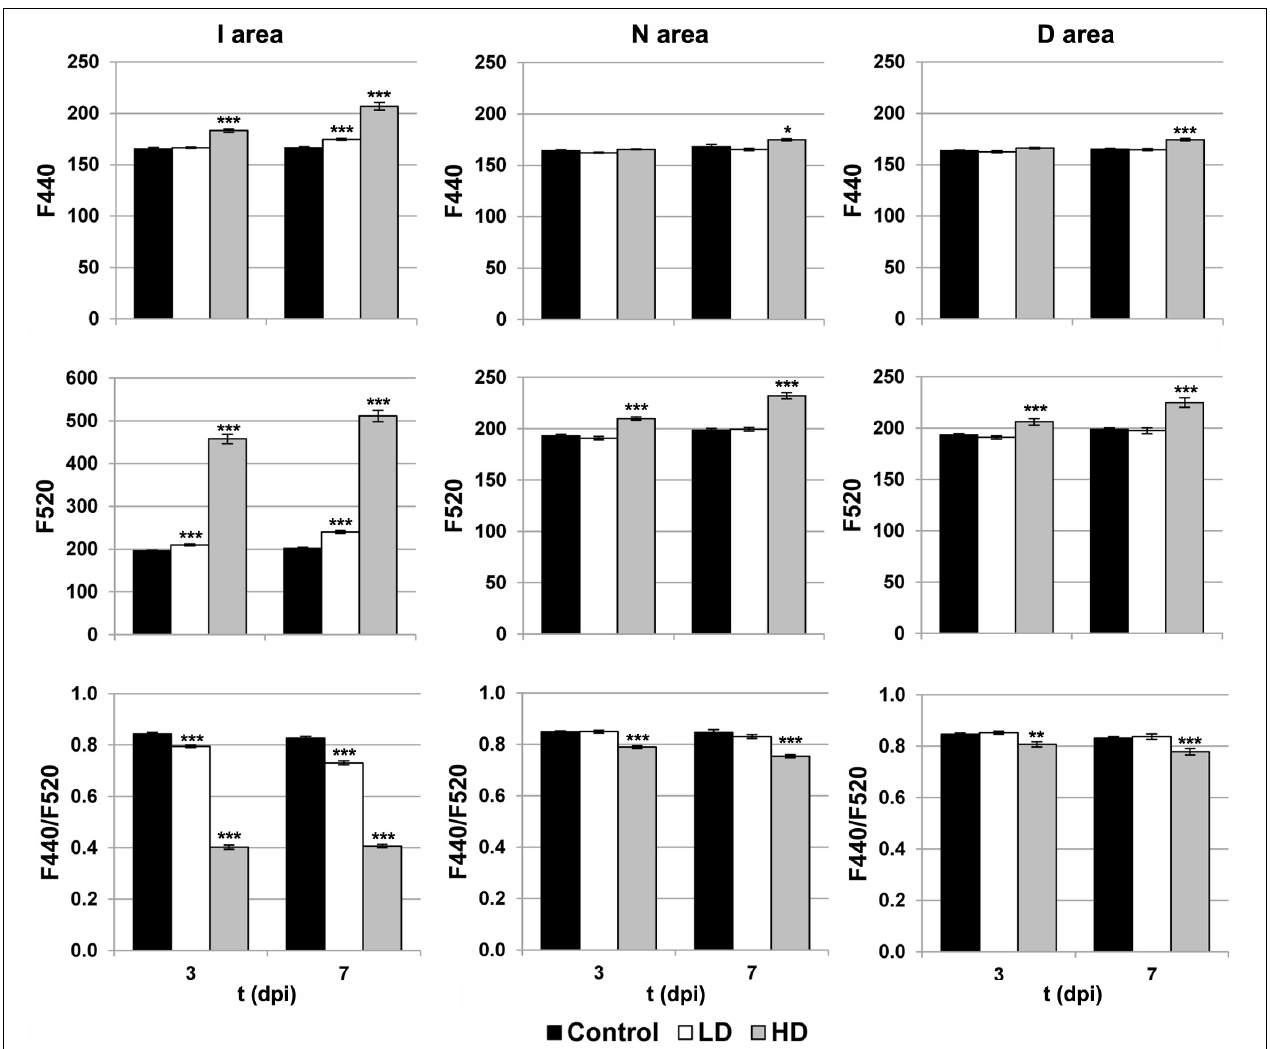
FIGURE 3 | Parameters obtained by MCFI in the I (inoculated), N (neighboring), and D (distant) areas of treated leaves. F440, fluorescence emitted at 440 nm; F520, fluorescence emitted at 520 nm; dpi, days post-inoculation; LD and HD, low and high bacterial dose (10 4 and 10 6 colony forming units ml − 1 , respectively). ∗ p < 0.1, ∗∗ p < 0.01, and ∗∗∗ p < 0.001, respectively, according to Student’s t -test.